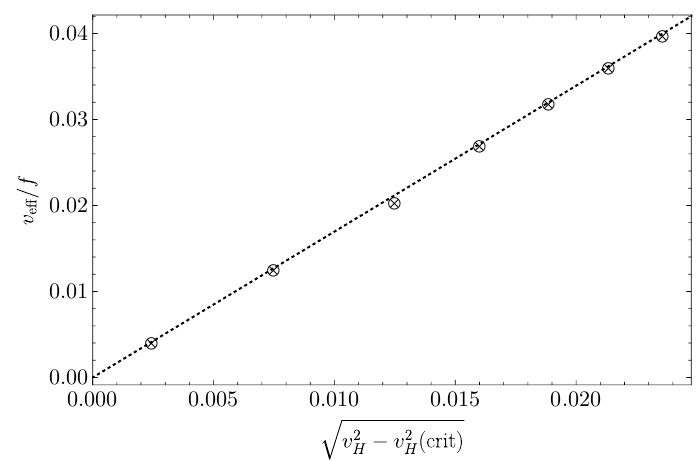
Figure 7. In this plot, we display the behavior of v e(cid:11) =f at the minimum of the radion potential for subcritical v 2 > v 2 (crit) as it approaches the critical region. The dashed line is a linear (cid:12)t to H H the numerical data forced to pass through the origin by adjusting v 2 (crit). The critical value is H determined in this manner to be v 2 (crit) = (cid:0) 16 : H